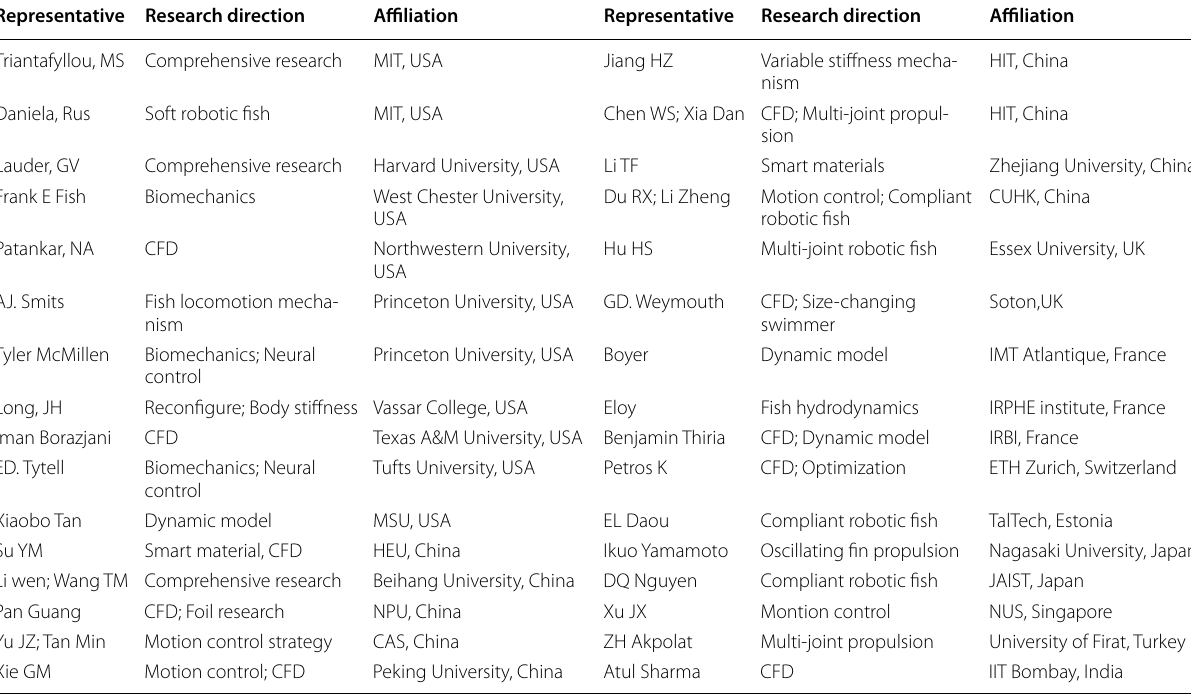
Table 1 Some research teams on fish swimming Representative Research direction Affiliation